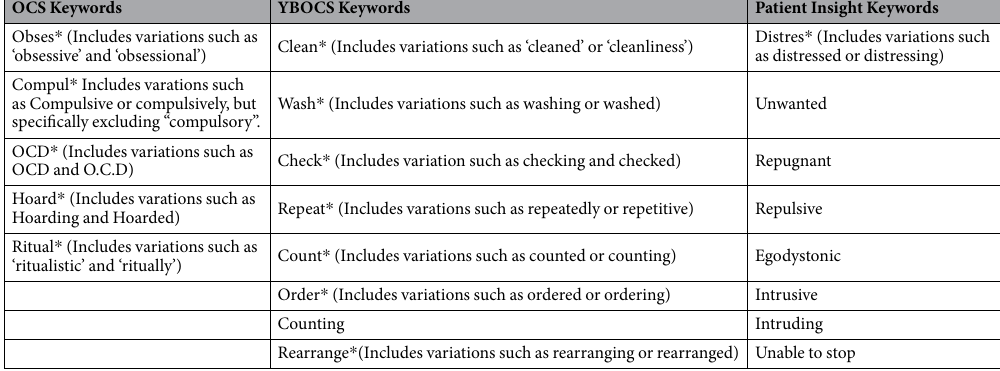
Table 1. Key modifier words used in the natural language processing application for